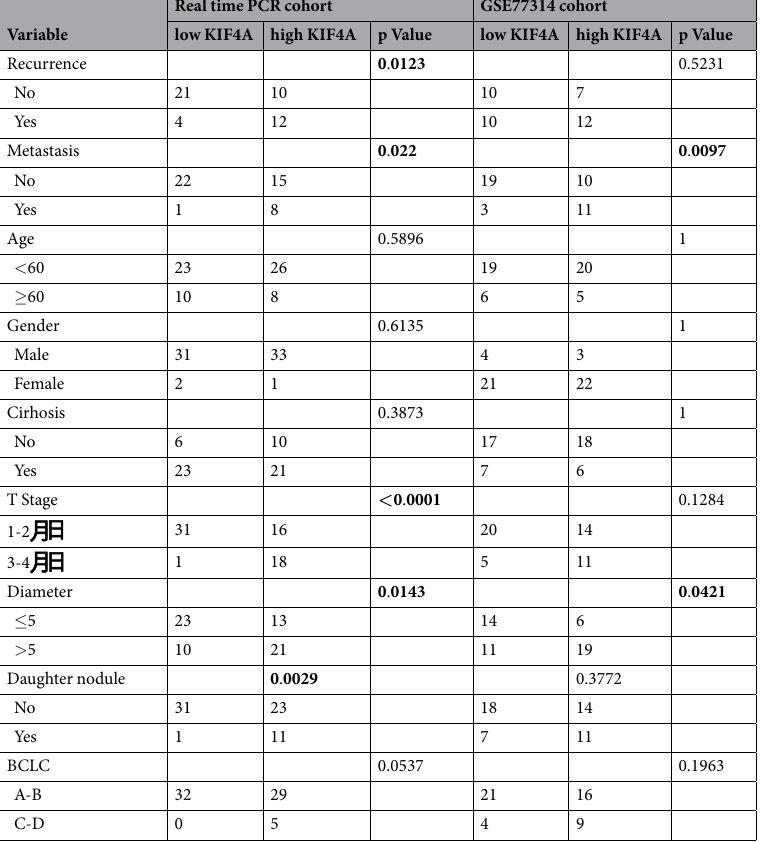
Table 1. The association between KIF4A expression and clinical information. The KIF4A-low and KIF4A-high group is classified according to the median expression level of KIF4A. * Some clinical information is